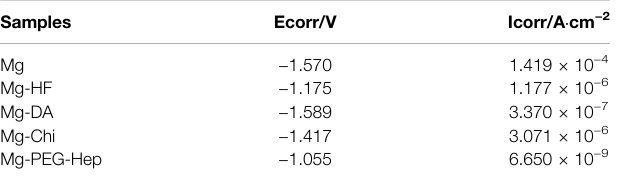
TABLE 3 | Surface element contents of the different samples after immersing in SBF for 14